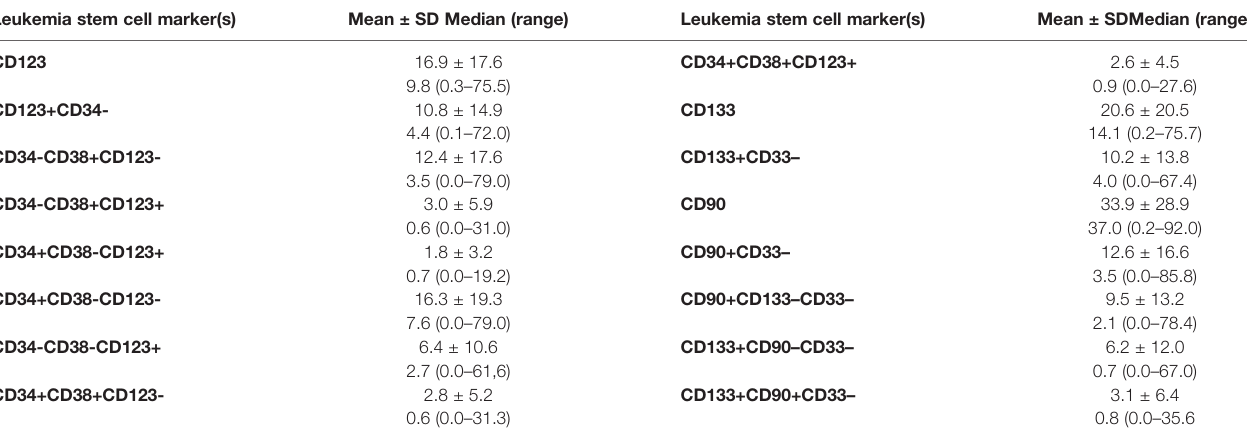
TABLE 2 | Leukemia stem cell frequency at diagnosis in 84 acute myeloid leukemia patients. Leukemia stem cell